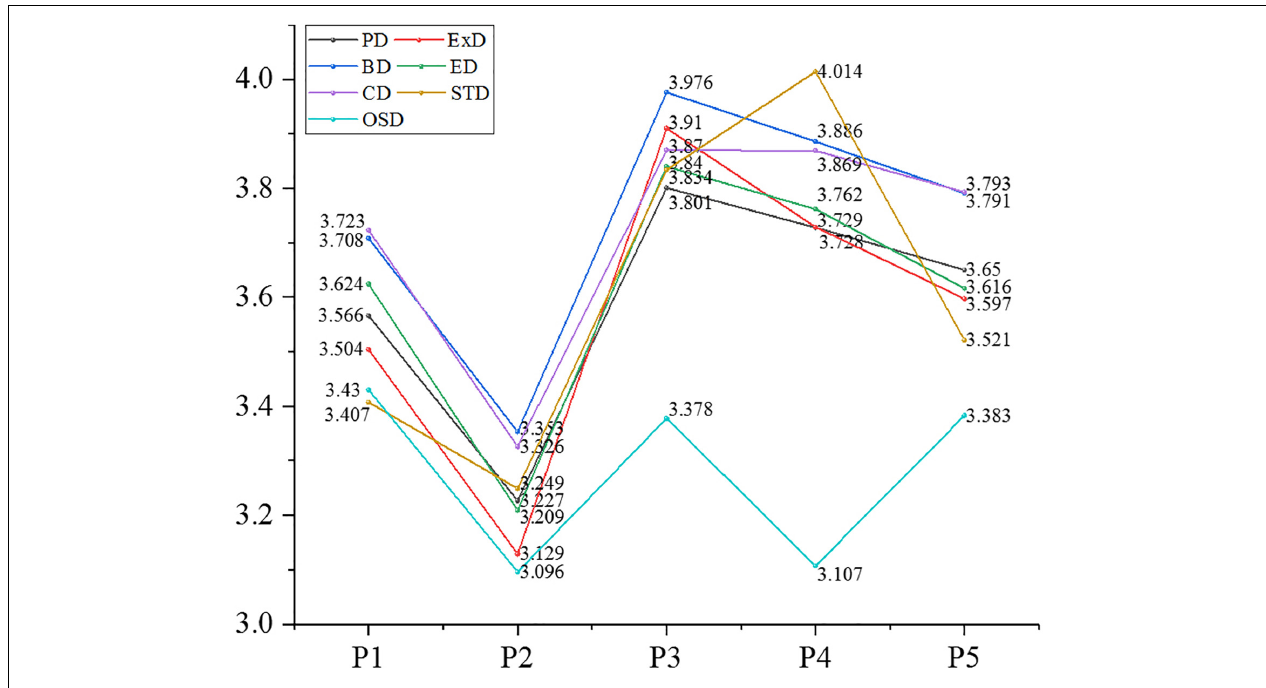
FIGURE 9 | Mean value of Psychological distance and dimensions thereof in the position level.